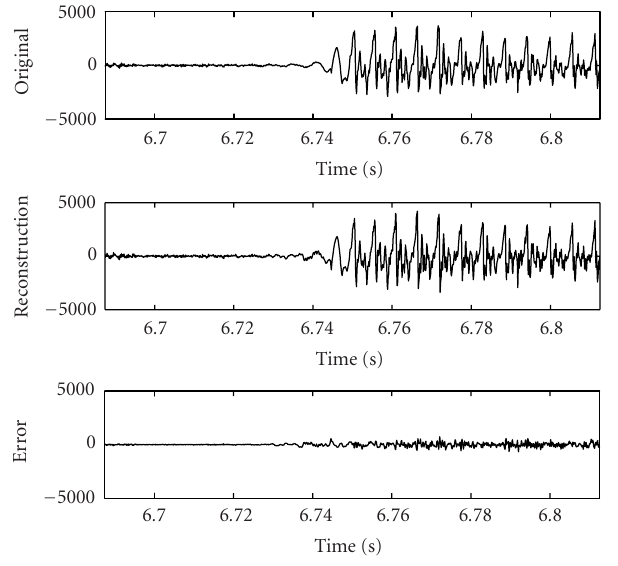
Figure 10: Original segment of a speech waveform (first plot) ver- sus reconstruction from decimated and quantized auditory repre- sentation with 40% channel erasures (middle) and the di ff erence between both (third plot).